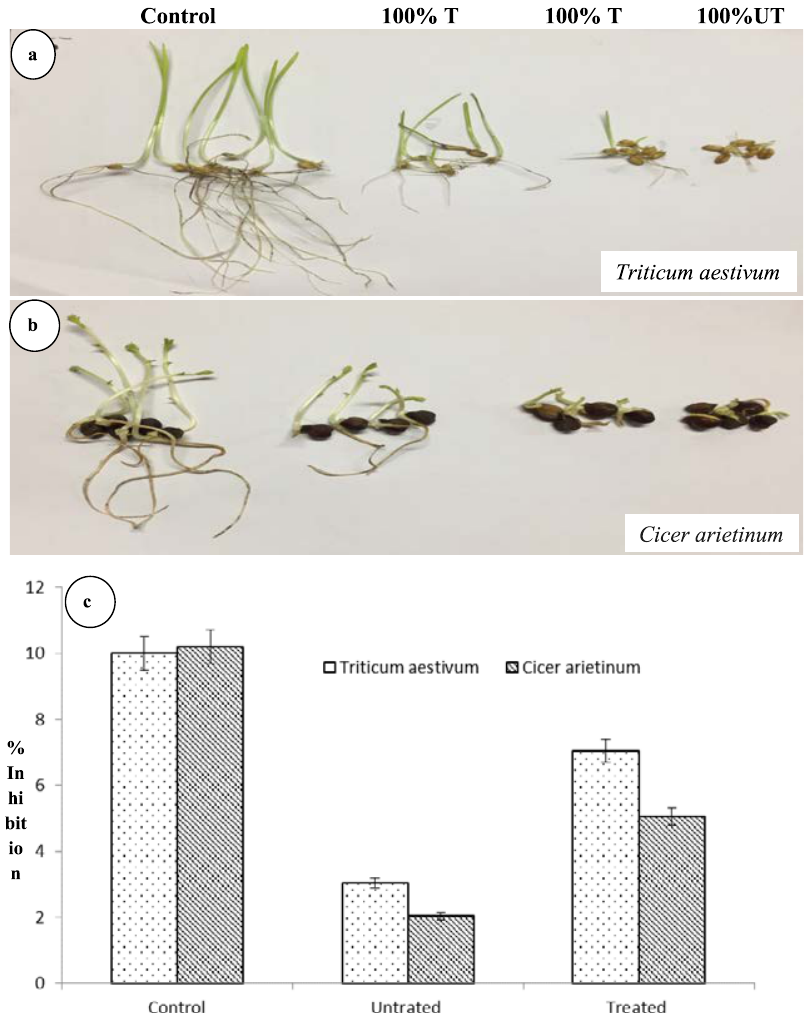
Fig. 7. Seed germination test by effluent of pulp paper industry untreated and bacterial treated on Triticum aestivum (a) Cicer arietinum (b) percent inhibition of seed germination (c), T-treated,